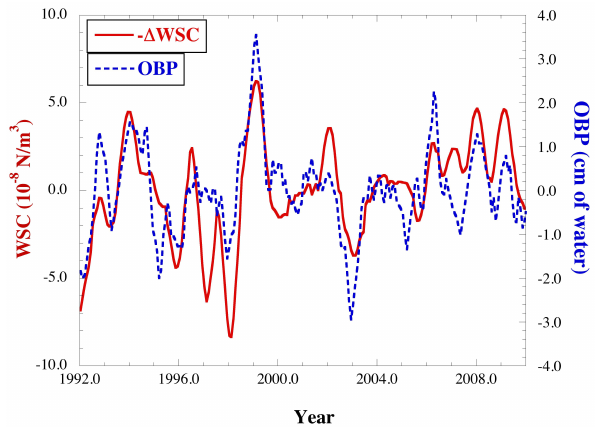
Fig. 5. Time-series of − 1 WSC (left axis) and OBP (right axis) from OMCT. The OBP data were averaged over the region 35 ◦ N– 45 ◦ N, 160 ◦ E–185 ◦ E as indicated by the box in Fig. 2. Data were low-pass filtered to isolate non-seasonal, low-frequency variations as described in Sect. 2. The negative value of 1 WSC is shown to better see the correspondence since OBP and 1 WSC are negatively correlated.